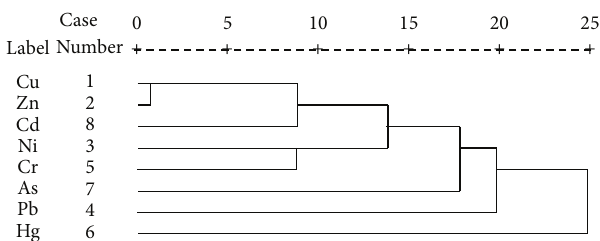
Figure 2: Dendrogram results from Pearson correlation coefficients of hierarchical cluster analysis for heavy metals.